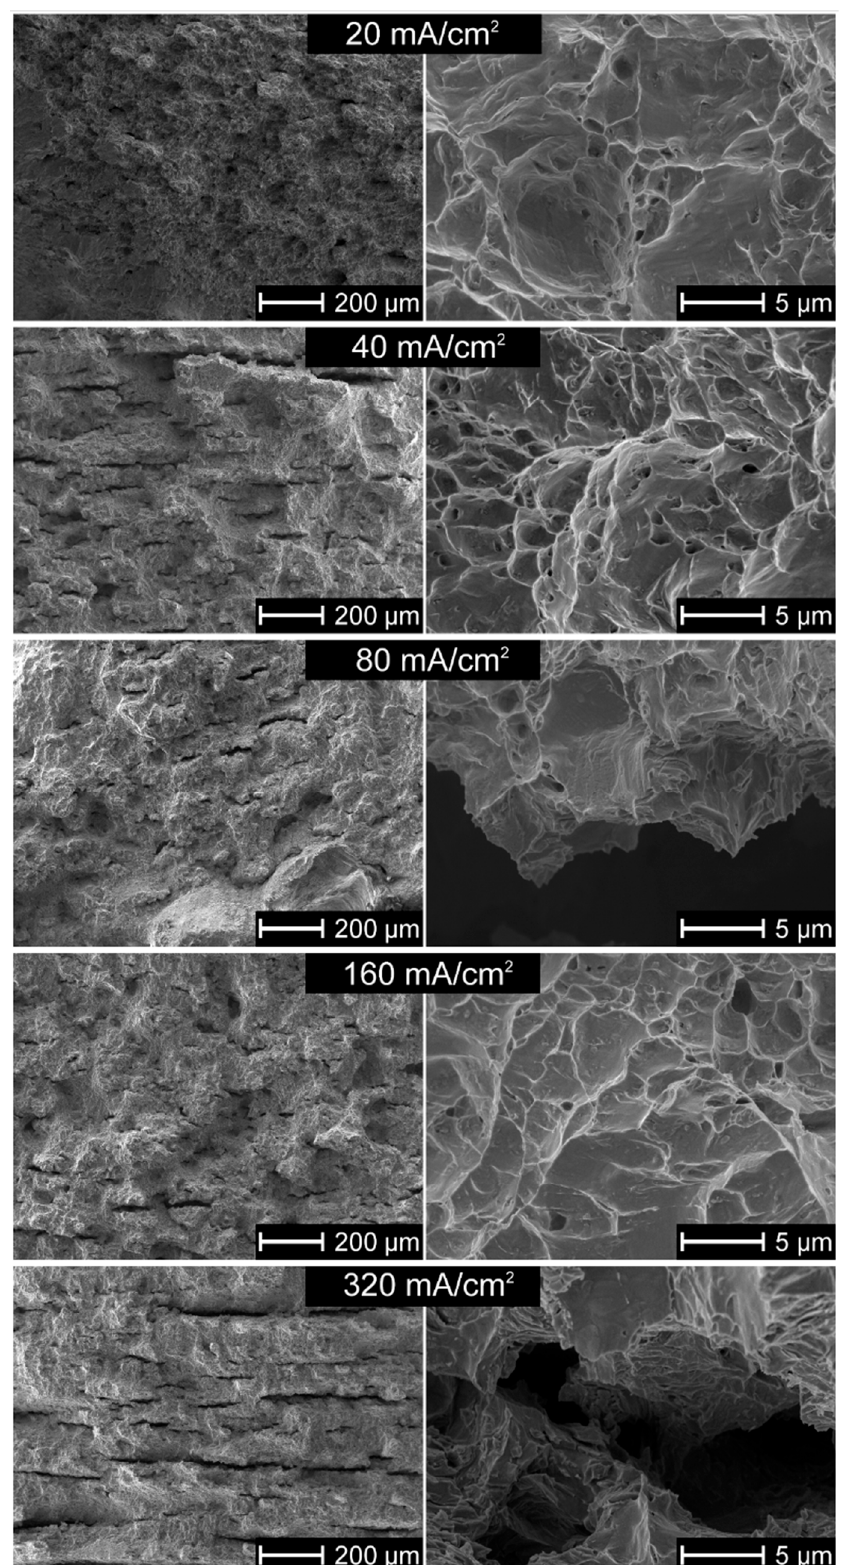
Figure 10. Fracture faces of nonoxidized specimens charged at different cathodic current densities.